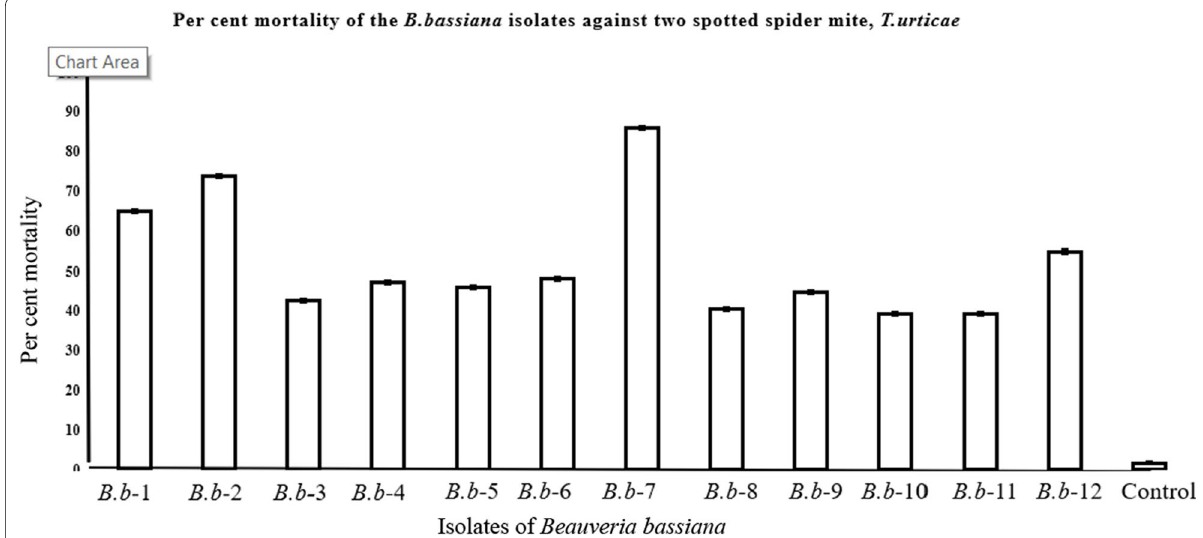
Fig. 4 Tetranychus urticae mortality in percentage after inoculation with various B. bassiana isolates at a spore concentration of 1